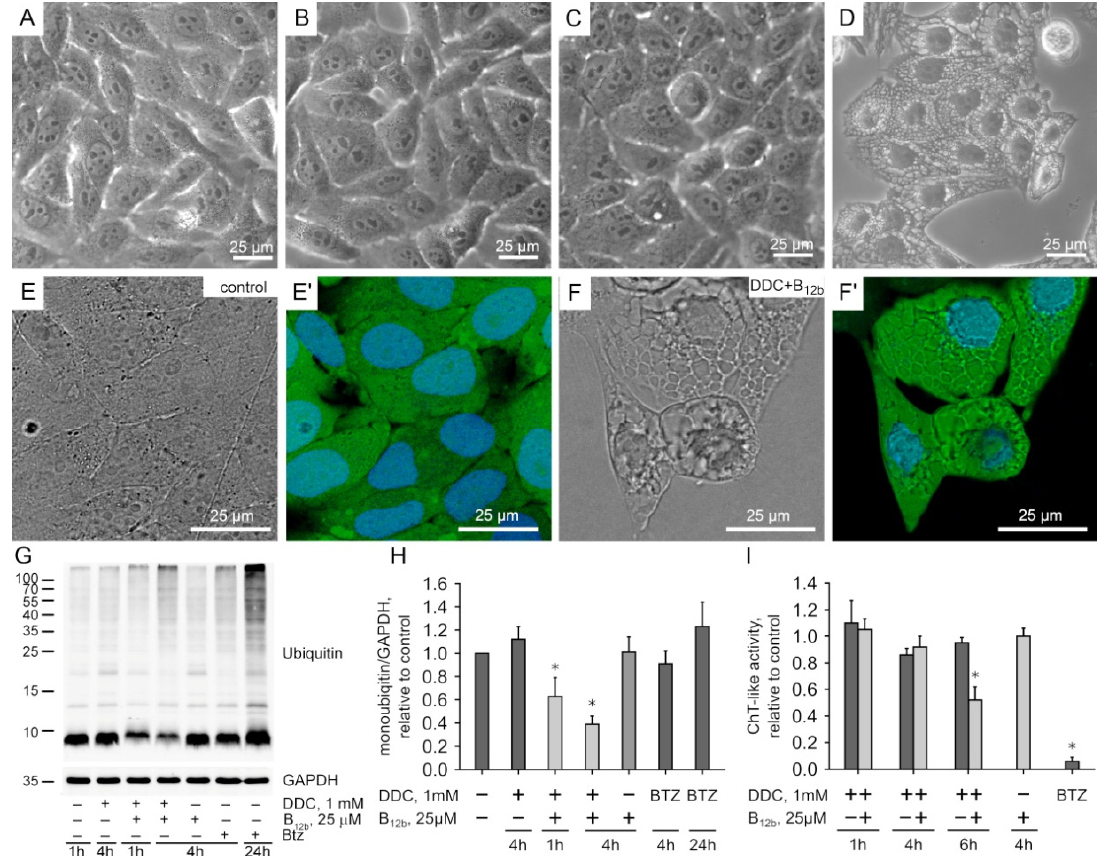
Figure 1. Oxidation of DDC catalyzed by B 12b induces vacuolization and paraptosis-like death of HEp-2 cells. ( A – D ) Phase-contrast images of cytoplasmic vacuoles in HEp-2 cells. ( A ) Untreated cells. ( B ) Cells treated with DDC (4 h). ( C , D ) Cells treated with DDC+B 12b for 1 h and 4 h. ( E , F ) Confirmation of protein synthesis in the vacuoles of HEp-2 cells during the initiation of their death through staining with 2 µ M CFSE from 3 to 4 h of incubation with DDC+B 12b . ( E , E’ ) Control. ( F , F’ ) Cells treated with DDC+B 12b for 4 h. ( G , H ) Immunoblot analysis of protein polyubiquitination and monoubiquitin levels in HEp-2 cells. ( I ) Estimation of 26S proteasome activity of HEp-2 cells during the initiation of their death using 1 mM DDC combined with 25 µ M B 12b . The data are the means ± s.e.m. of three separate experiments. *, Significant differences between the samples and the control, p < 0.05.